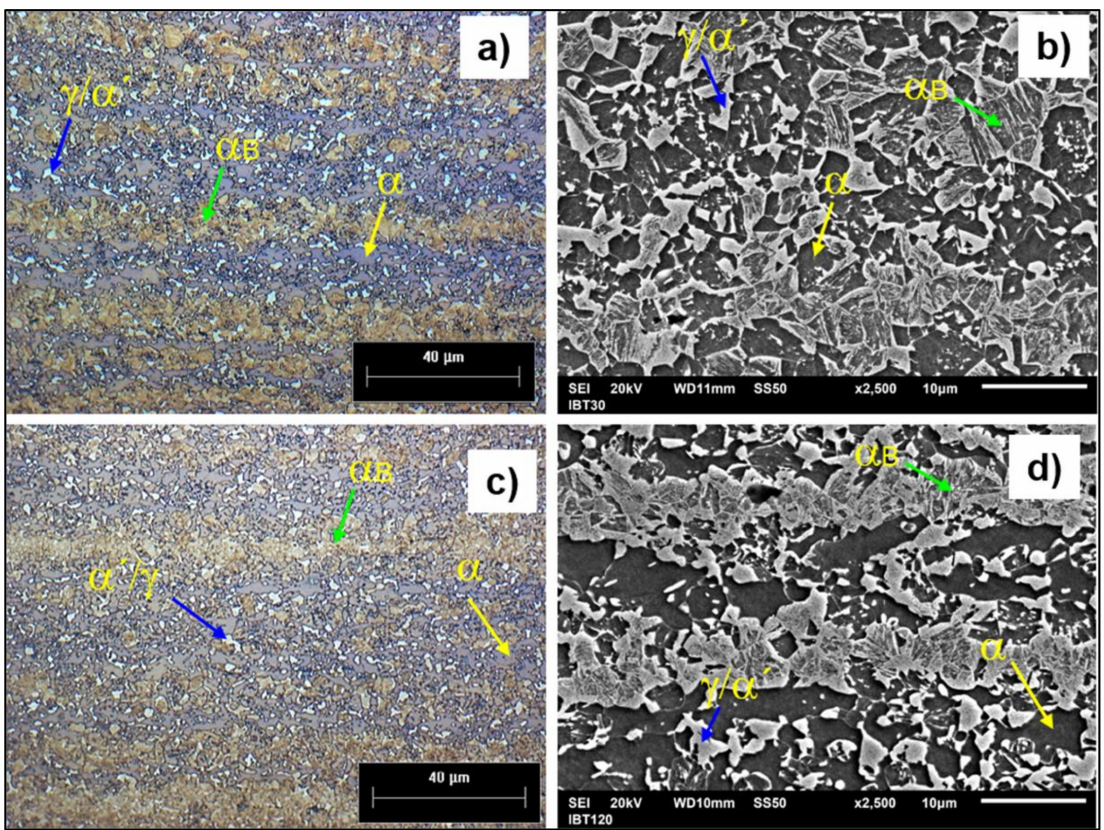
Figure 7. Microstructure of samples resulting from annealing at 800 ◦ C—15 s and isothermal treatment at 450 ◦ C with different holding times: ( a , b ) 30 s and ( c , d ) 120